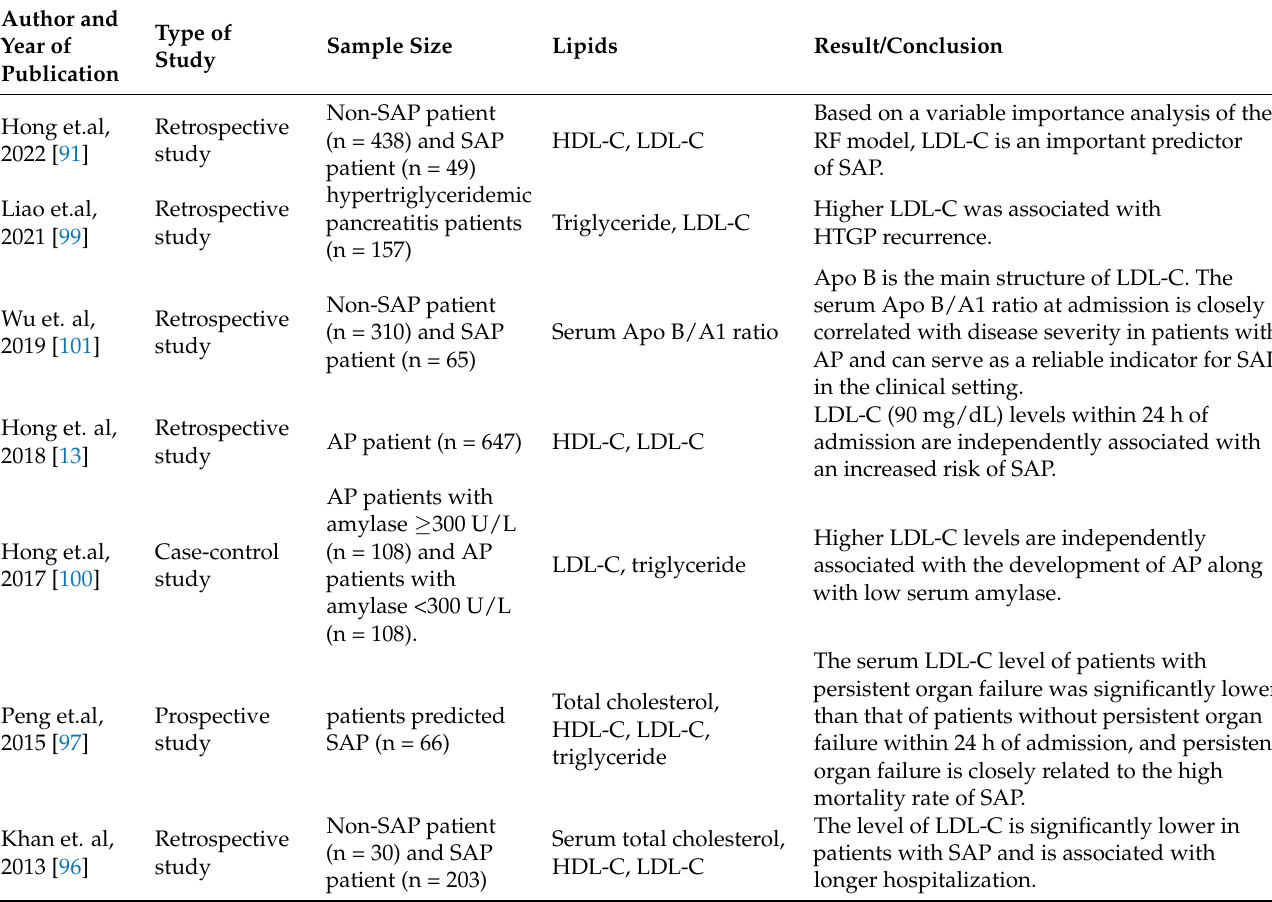
Table 2. Characteristics of included clinical studies related to the relationship between LDL-C and AP.